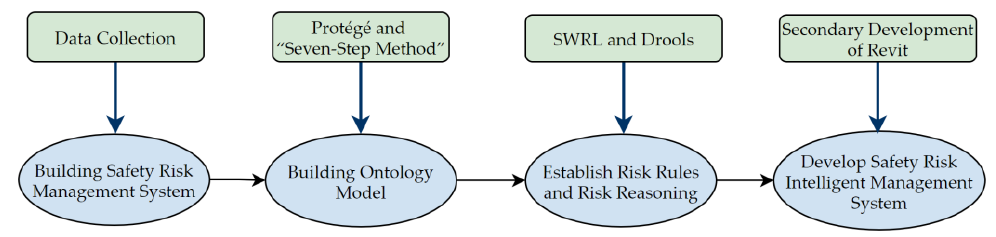
Figure 1. Research